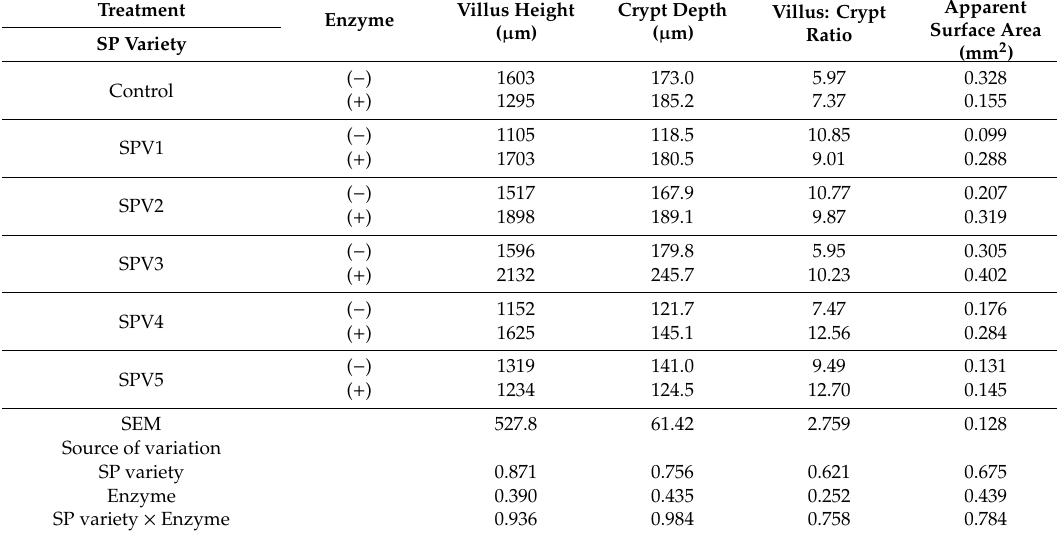
Table 9. Dietary e ff ects on morphological changes in the jejunum of